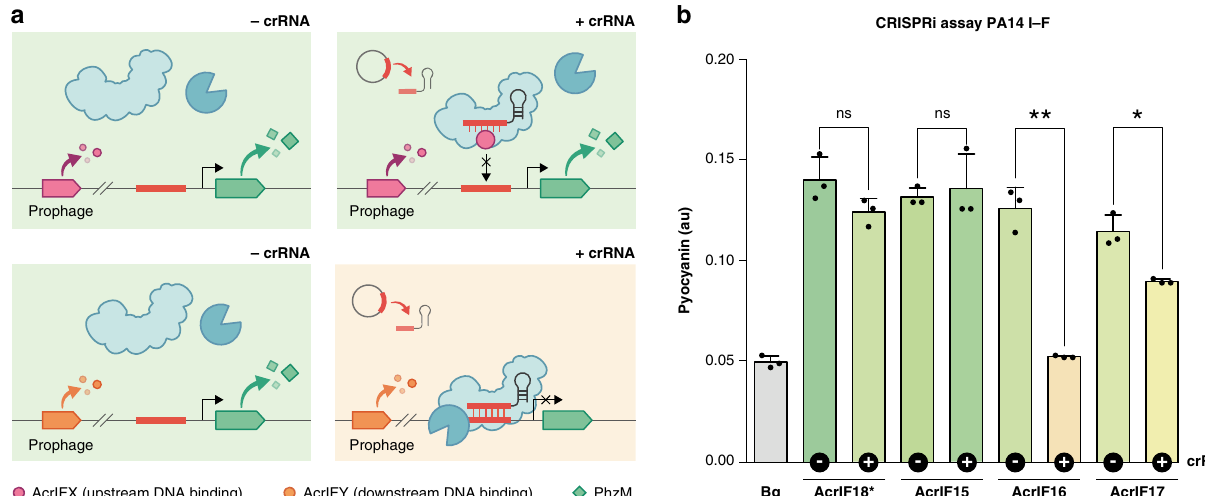
Fig. 4 AcrIF18* and AcrIF15 prevent type I – F CRISPRi. a Schematic of the CRISPRi assay. In the absence of a crRNA, phzM is transcribed (green